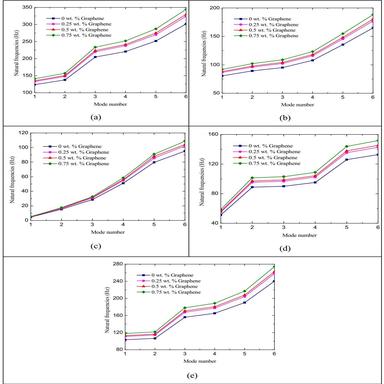
The effect of graphene wt% on the natural frequencies of GFRP composite panel under different end conditions (a) CCCC (b) CFCF (c) CFFF (d) SFSF (e) SSSS.